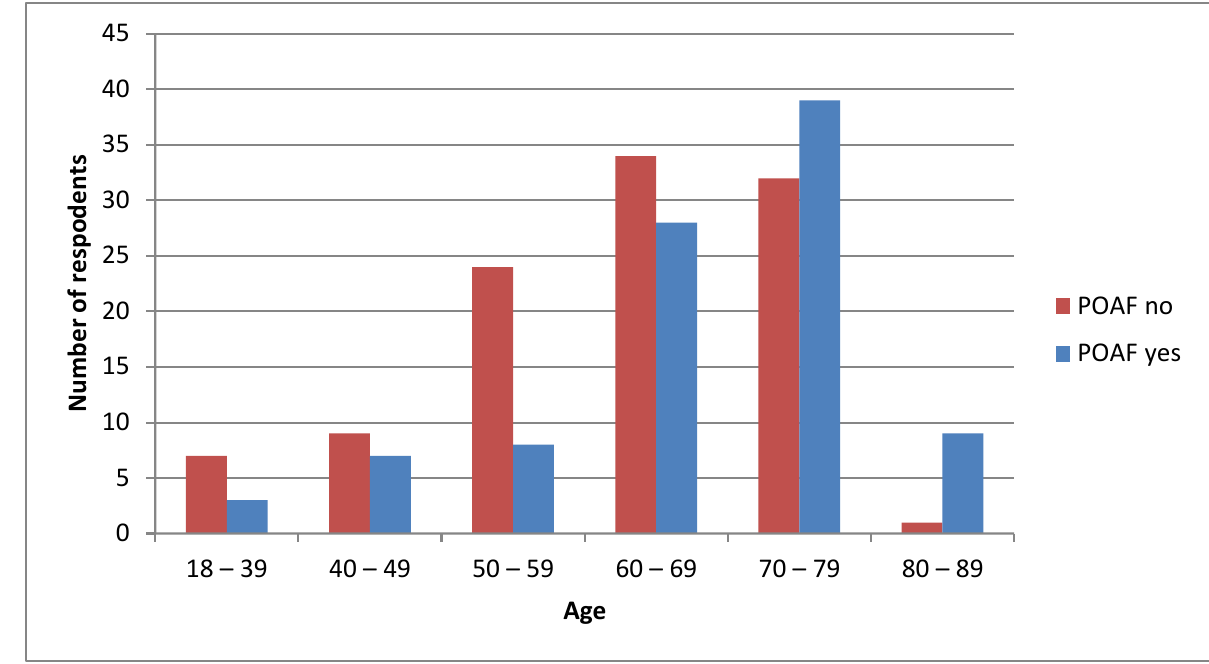
Figure 1. Prevalence of postoperative AF by age. Figure 2 represents prevalence of postoperative AF by body weight, whereas most partici- pants between 81 and 90 k g had AF. They are followed by 26 participants who weighed between 71 and 80 k g but did not develop AF. weight with the AF prevalence (r = −0.08, p = 0.292).